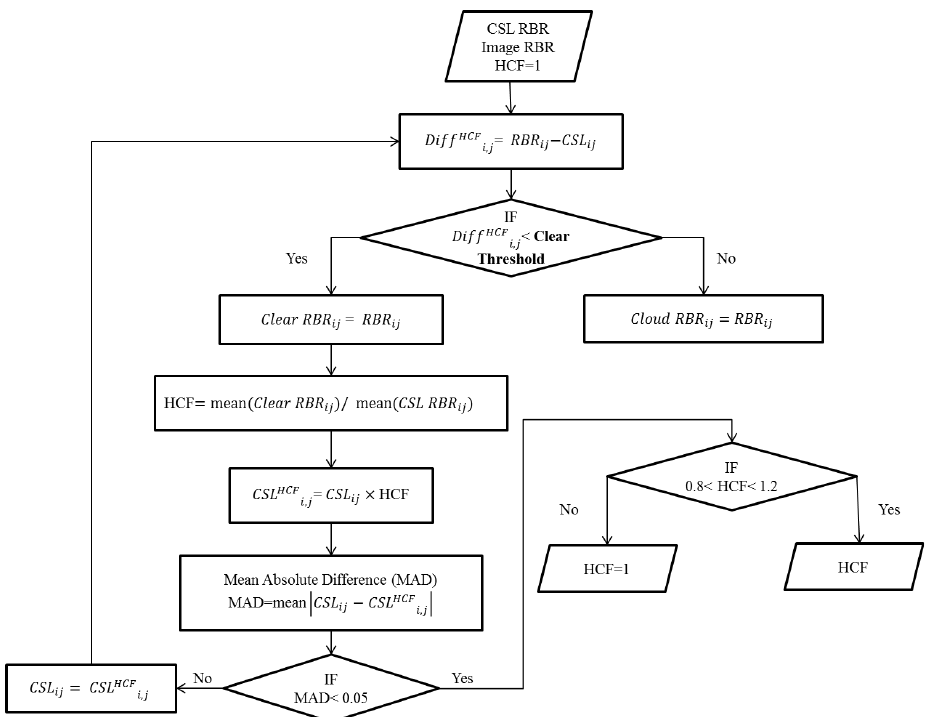
Figure 5. Flow chart for determining HCF which is executed pixel-by-pixel. The first box represents the initialization of HCF, RBR, and CSL. Since the selection of clear pixels also depends on HCF (see 3rd box from the top), the HCF must be obtained iteratively. ( i , j ) denote the pixel number in the image.